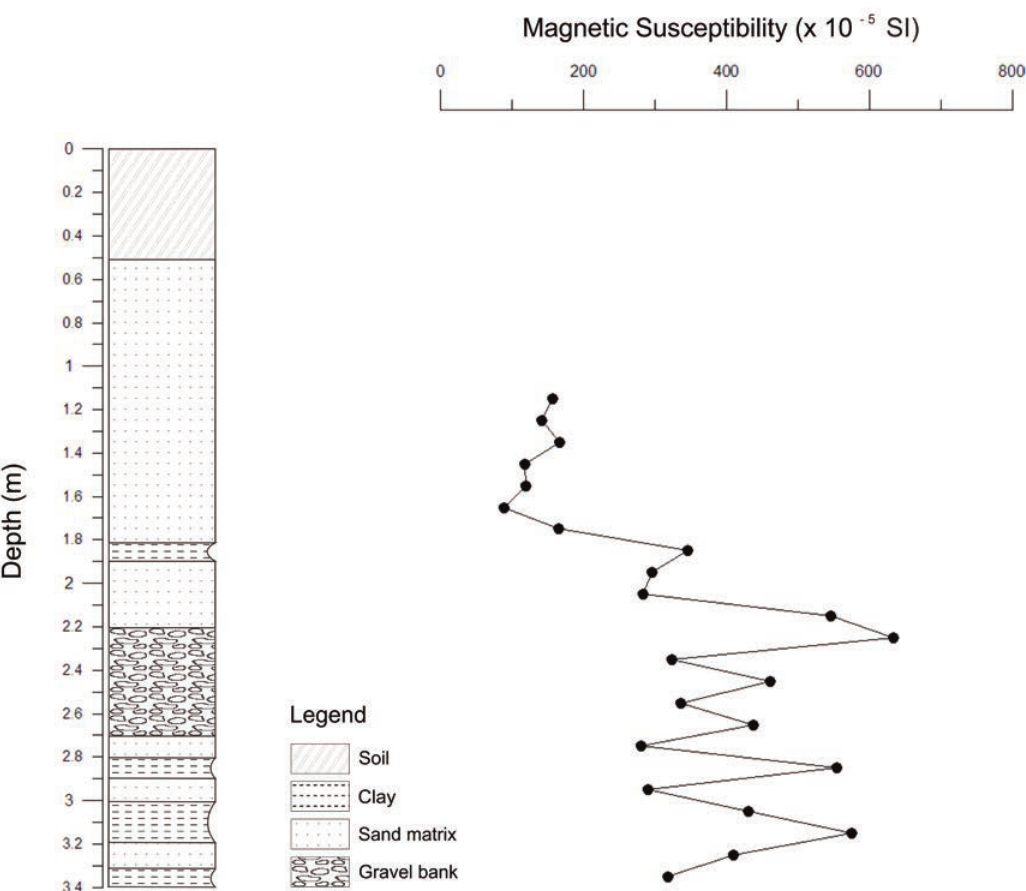
Figure 7. Lithostratigraphic column and magnetic susceptibility log of a section of the Sorano unit 2